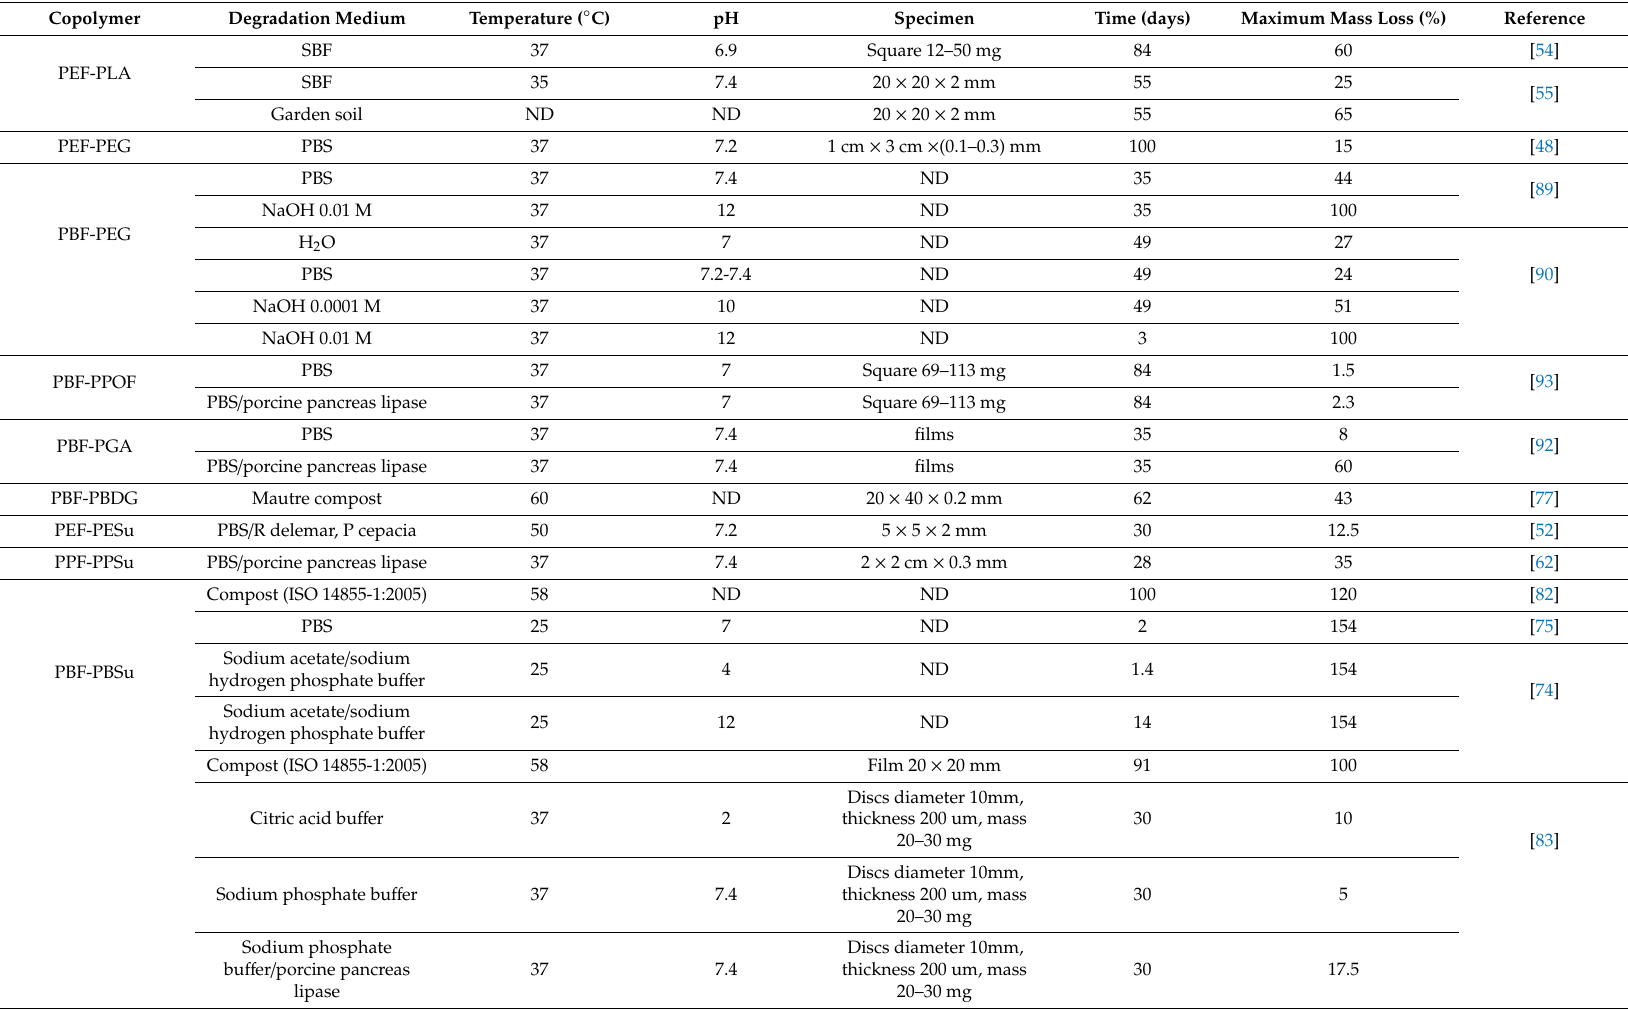
Table A2. A summary of the biodegradation studies reported on furan-based copolyesters. ND = not